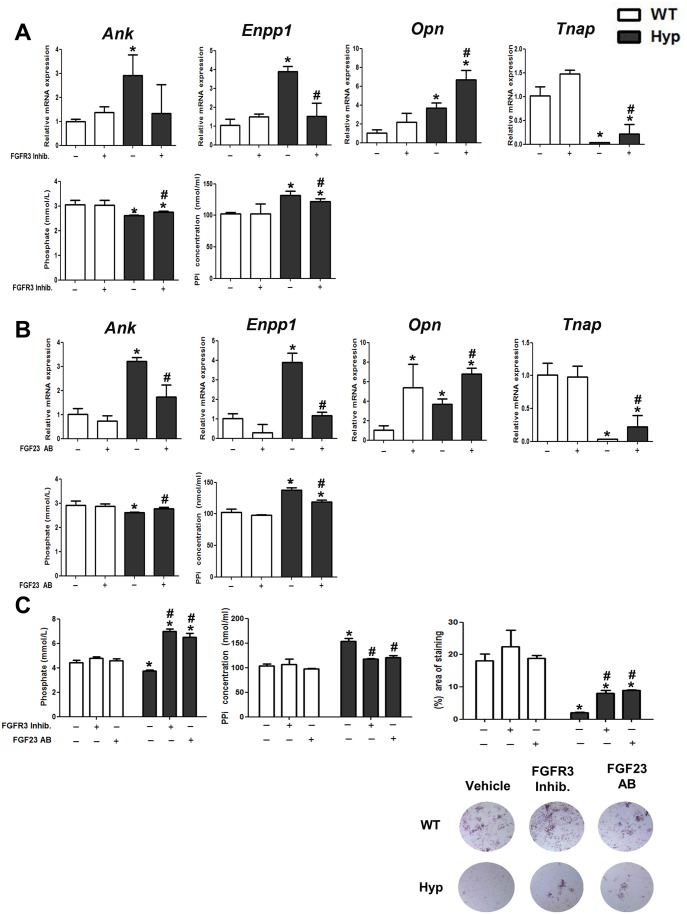
Inhibition of Fgf23-FGFR3 signaling increases TNAP expression and lowers PPi concentration in Hyp-derived osteocyte-like cells.
(A–B)
Ank, Enpp1, Opn and Tnap mRNA abundance as well as Pi and PPi concentration in cell culture supernatant of calvarial osteocyte-like cells differentiated for 22 d and treated for 24 h with a FGFR3 inhibitor (A) or anti-FGF23 antibody (FGF23 AB) (B). (C) Phosphate and PPi concentration in cell culture supernatant as well as percent NBT/BCIP-stained area in cultures of calvarial osteocyte-like cells differentiated for 22 d, and treated daily over 4 d with a FGFR3 inhibitor or FGF23 AB. Each data point is the mean ± SD of four experimental samples. Individual values are given in S1 Data. *, p < 0.05 versus vehicle-treated WT cells, #, p < 0.05 versus vehicle-treated Hyp cells.